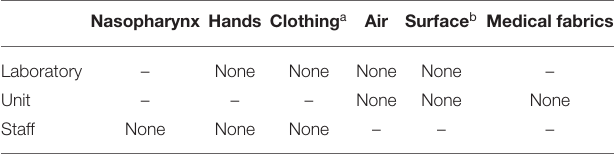
TABLE 1 | Screening of methicillin-resistant S. aureus (MRSA) colonization and contamination in the unit and laboratory. Nasopharynx Hands Clothing a Air Surface b Medical fabrics